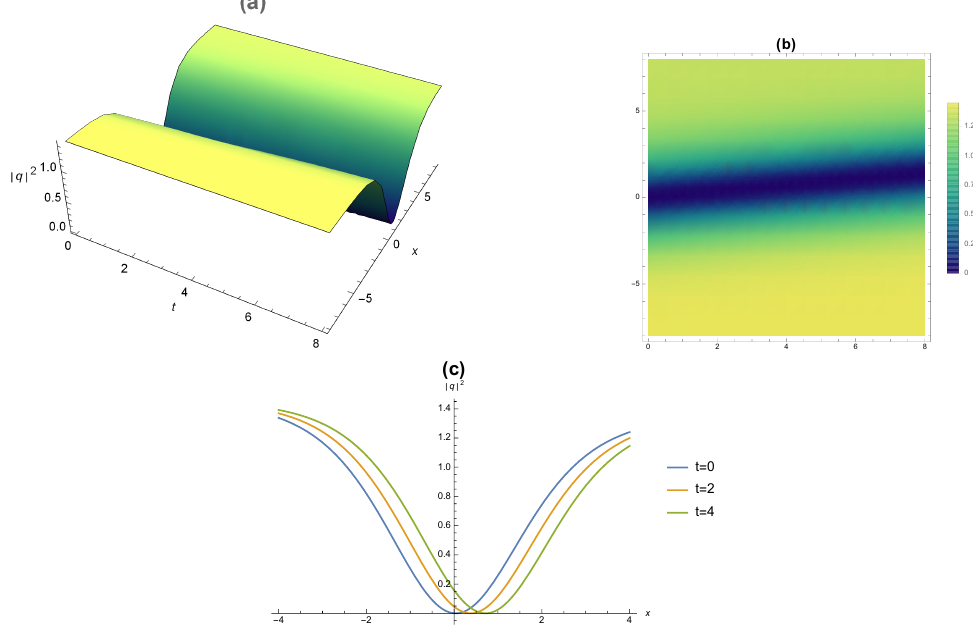
Figure 2. Represents a dark soliton solution (20) with appropriate values of parameters, n = 0.5; k = 1; a = − 1.78; α = − 1.8; β = − 0.64; γ = 0.46; v = 0.17; κ = − 1.17; ω = − 0.09; b 3 = − 0.13; b 4 = − 1.96. ( a ) is a 3D graph describing the structure of the soliton, and ( b ) is a contour that can describe the soliton’s propagation, while ( c ) is a 2D graph depicting the propagation of the soliton waves along x-direction for different